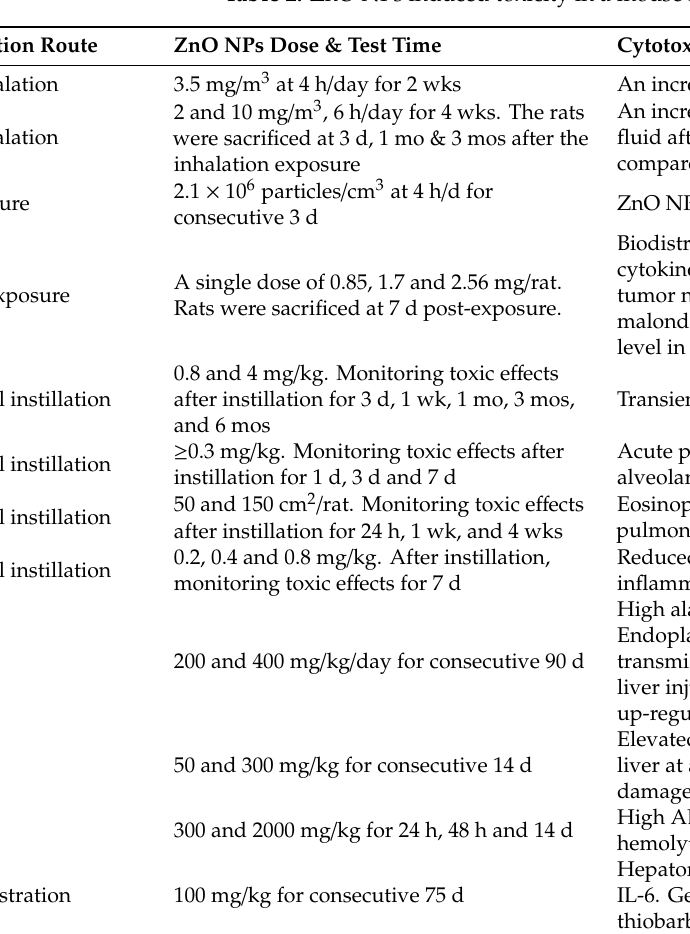
Table 2. ZnO NPs induced toxicity in a mouse model through di ff erent administration